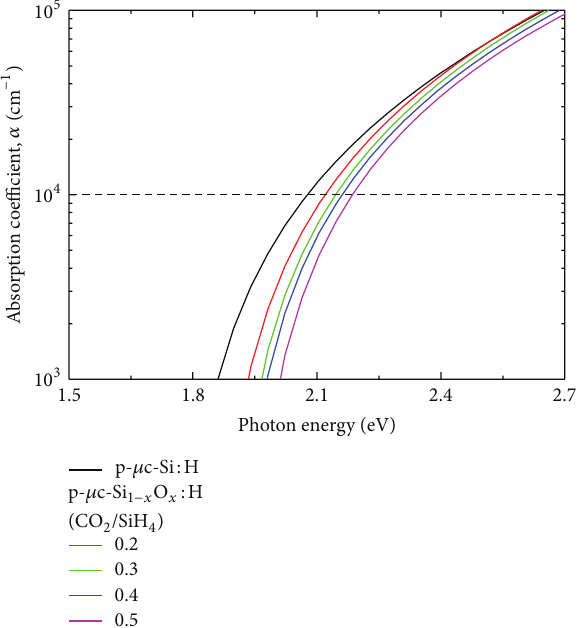
Figure 2: Dependence of the absorption coefficient on the CO 2 / SiH 4 ratio for p- 𝜇 c-Si 1−𝑥 O 𝑥 films.